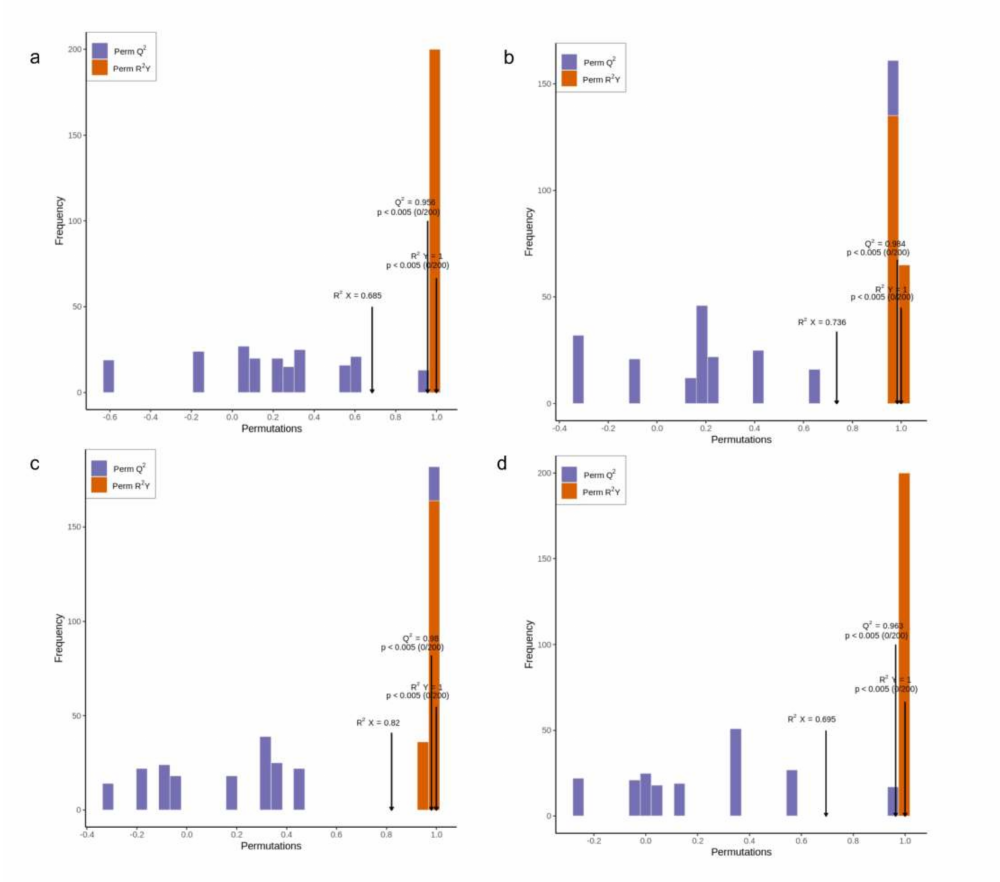
Figure 3. Related permutation tests in OPLS-DA. The X-axis represents the accuracy of the model, and the Y-axis represents the frequency of model classification effect. ( a ): 1 y and 3 y; ( b ): 3 y and 7 y; ( c ): 7 y and 14 y; ( d ): 14 y and 25